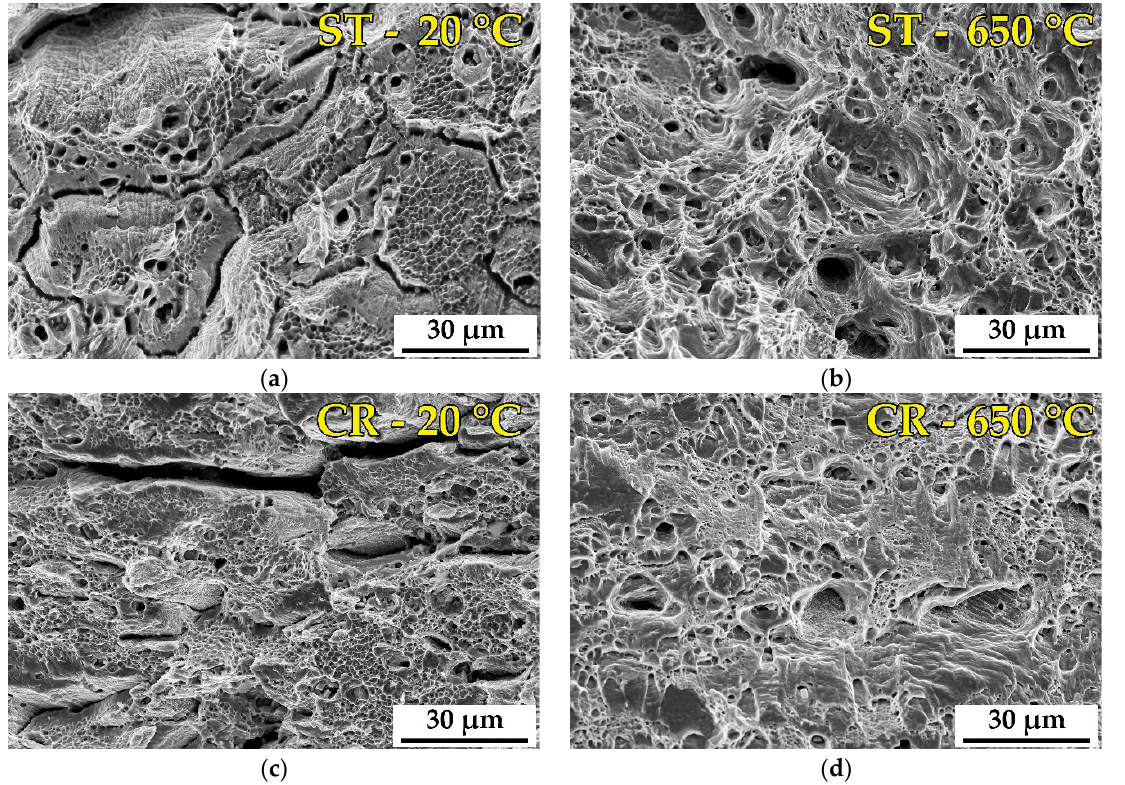
Figure 10. Fractographic images of the central part of tensile steel samples after ST ( a , b ) and CR ( c , d ), fractured at 20 °C ( a , c ) and 650 °C ( b , d ).